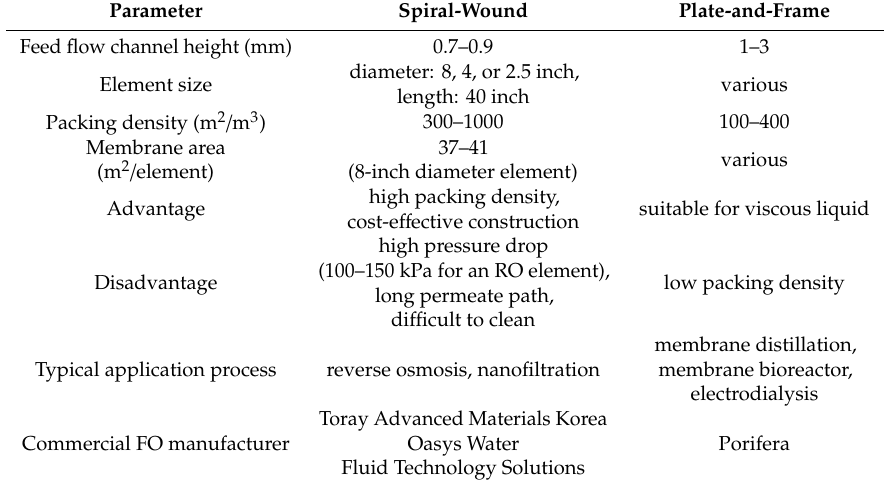
Table 1. Typical characteristics for spiral-wound and plate-and-frame membrane modules and the commercial forward osmosis (FO) membrane manufacturers